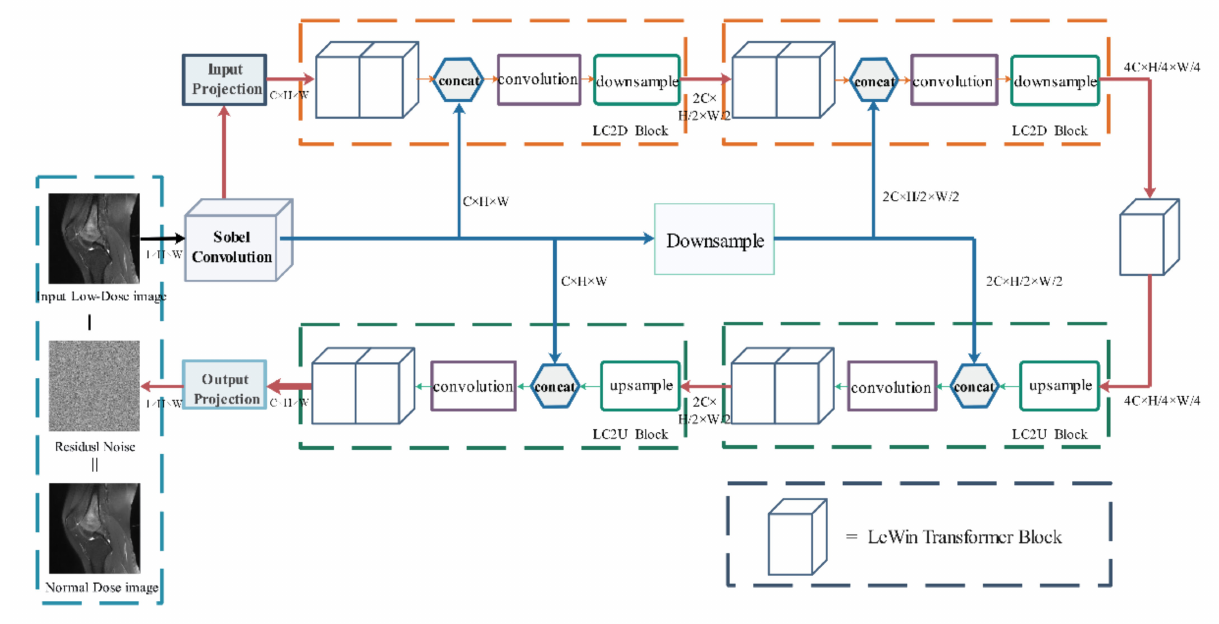
Figure 2. Eformer model structure